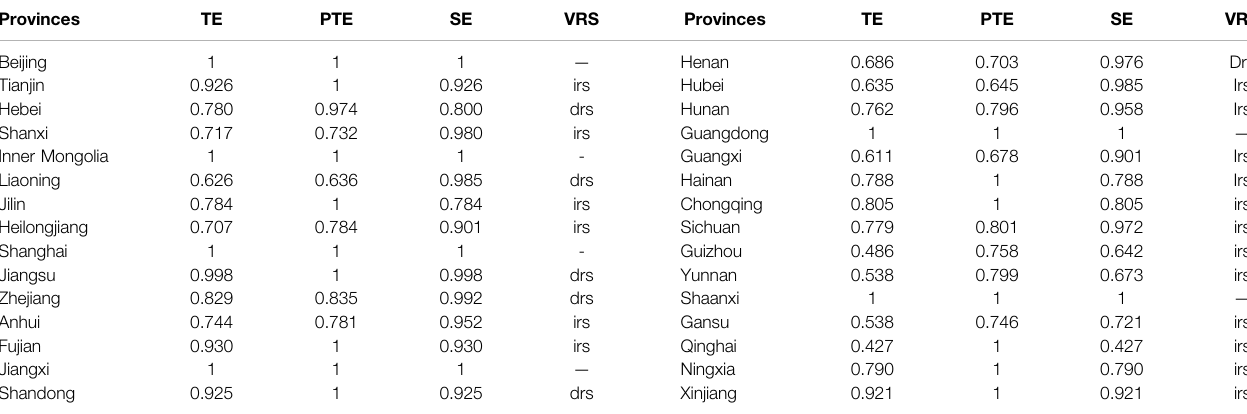
TABLE 5 | GTFP and its breakdown over provinces in 2018. Provinces